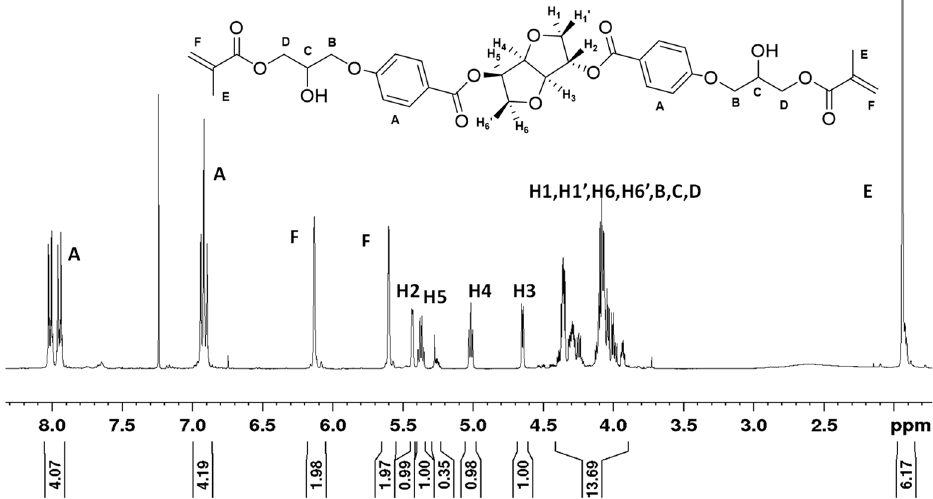
Figure 7. 1 H NMR Isosorbide 2,5-bis(4-glycerloxybenzoate) dimethacrylate.